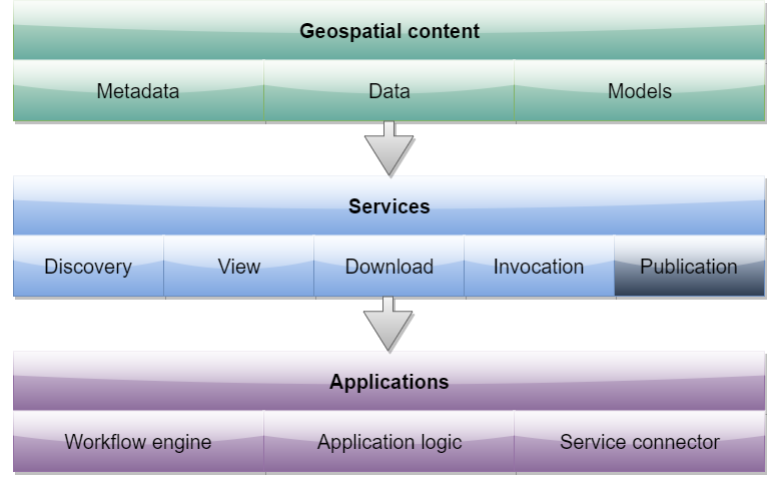
Figure 2. Proposed extended SDI architecture.